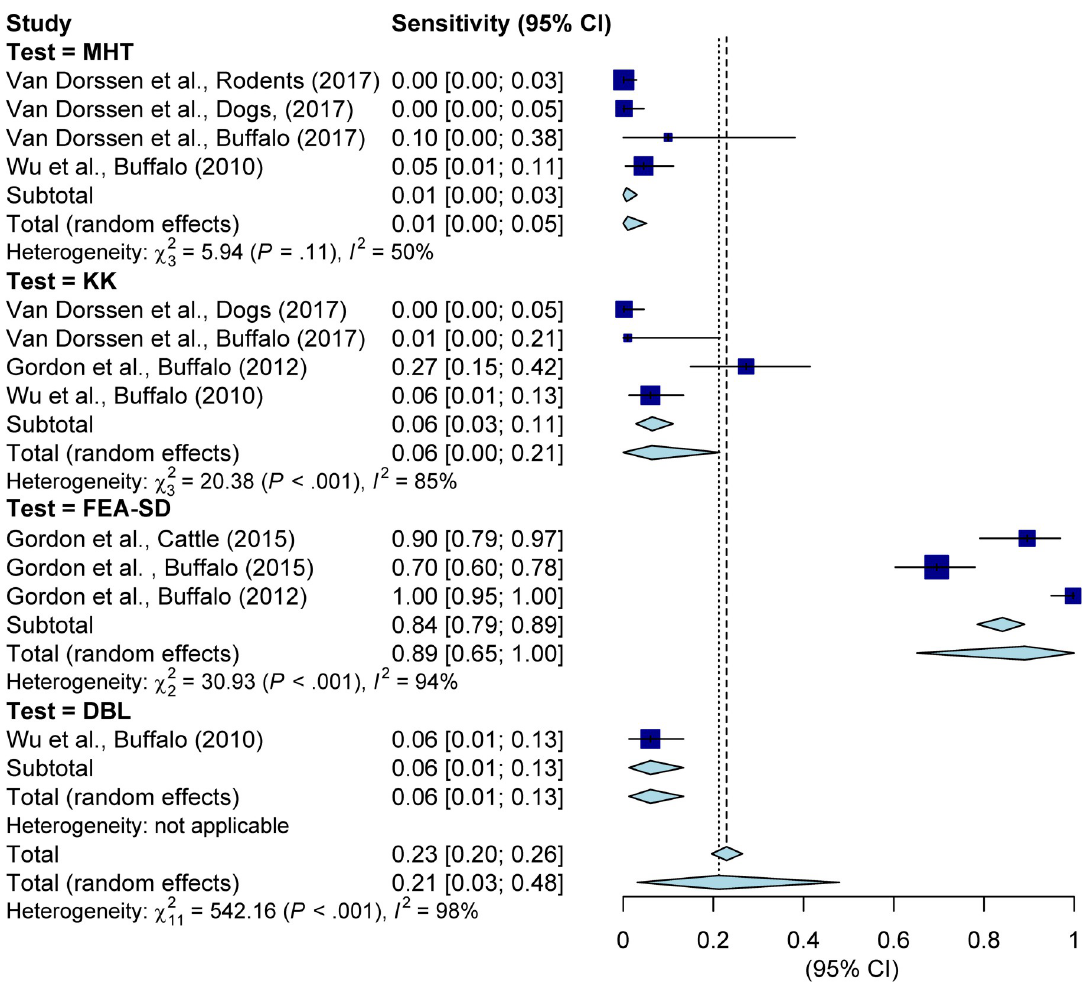
Fig 2. Meta-analysis of sensitivity of selected diagnostic techniques for the diagnosis of schistosome in non-human animals.